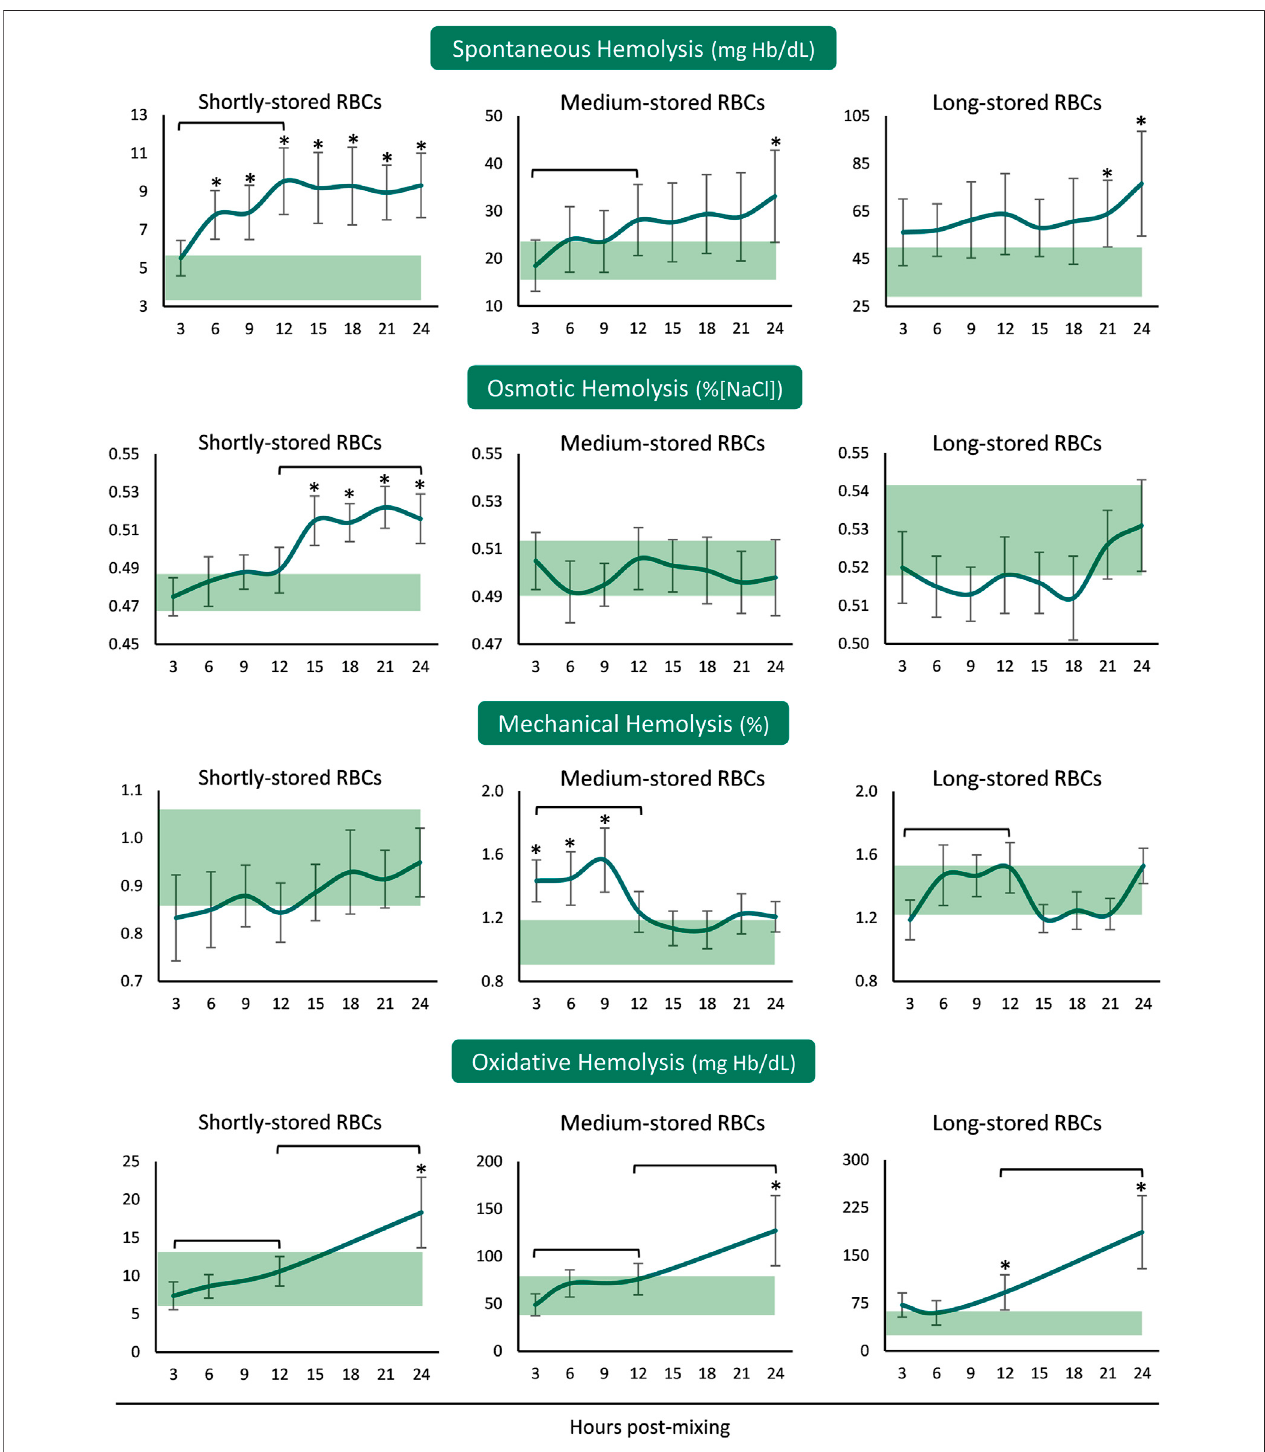
FIGURE 1 | Hemolysis parameters of reconstituted stored red blood cells in freshly drawn plasma. Baseline levels of stored RBCs in the cold (4 ° C) are shown by transparent horizontal bands (band thickness is representative of the standard deviation [SD]). (*) p < 0.050 reconstituted RBCs vs. baseline RBCs in the cold; brackets show differences with p < 0.050 between 3, 12, and 24 h post reconstitution.